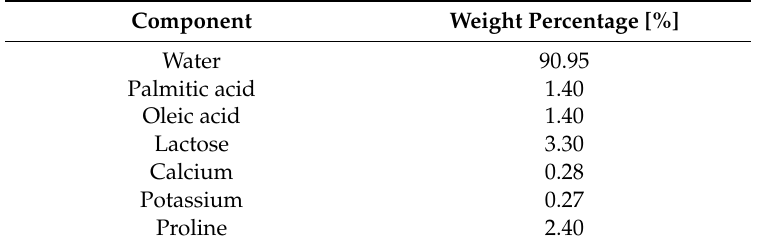
Table 1. Composition of fresh pasteurized whole milk in the Aspen Plus model.